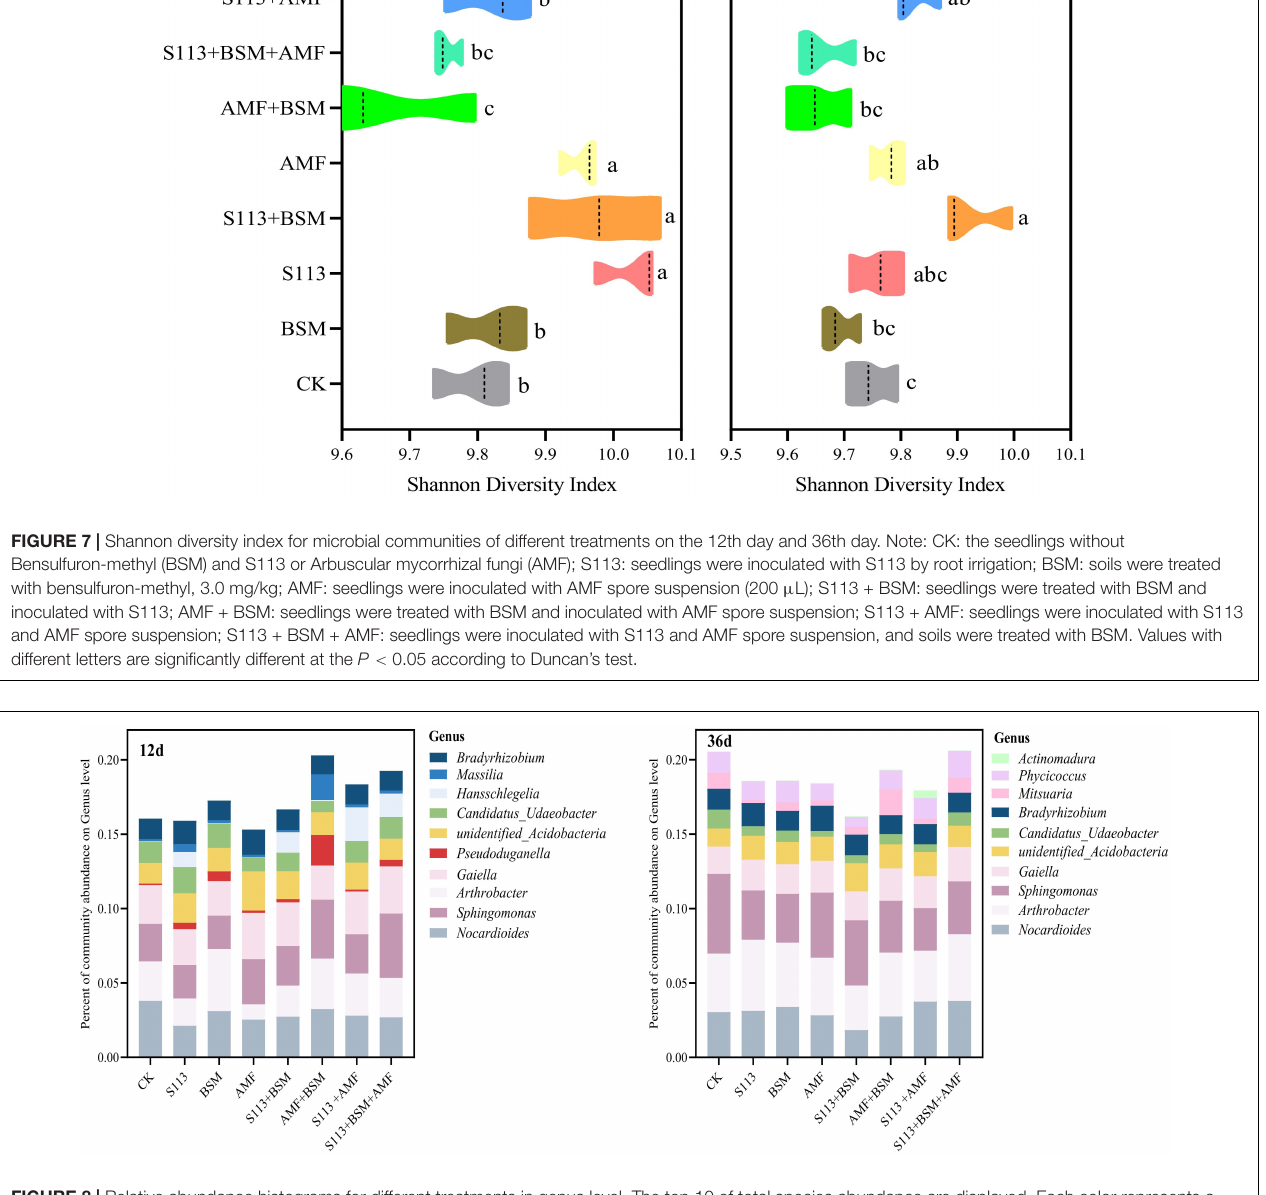
FIGURE 8 | Relative abundance histograms for different treatments in genus level. The top 10 of total species abundance are displayed. Each color represents a different genus level species. CK: the seedlings without BSM and S113 or AMF; S113: seedlings were inoculated with S113 by root irrigation; BSM: soils were treated with bensulfuron-methyl, 3.0 mg/kg; AMF: seedlings were inoculated with AMF spore suspension (200 µ L); S113 + BSM: seedlings were treated with BSM and inoculated with S113; AMF + BSM: seedlings were treated with BSM and inoculated with AMF spore suspension; S113 + AMF: seedlings were inoculated with S113 and AMF spore suspension; S113 + BSM + AMF: seedlings were inoculated with S113 and AMF spore suspension, and soils were treated with